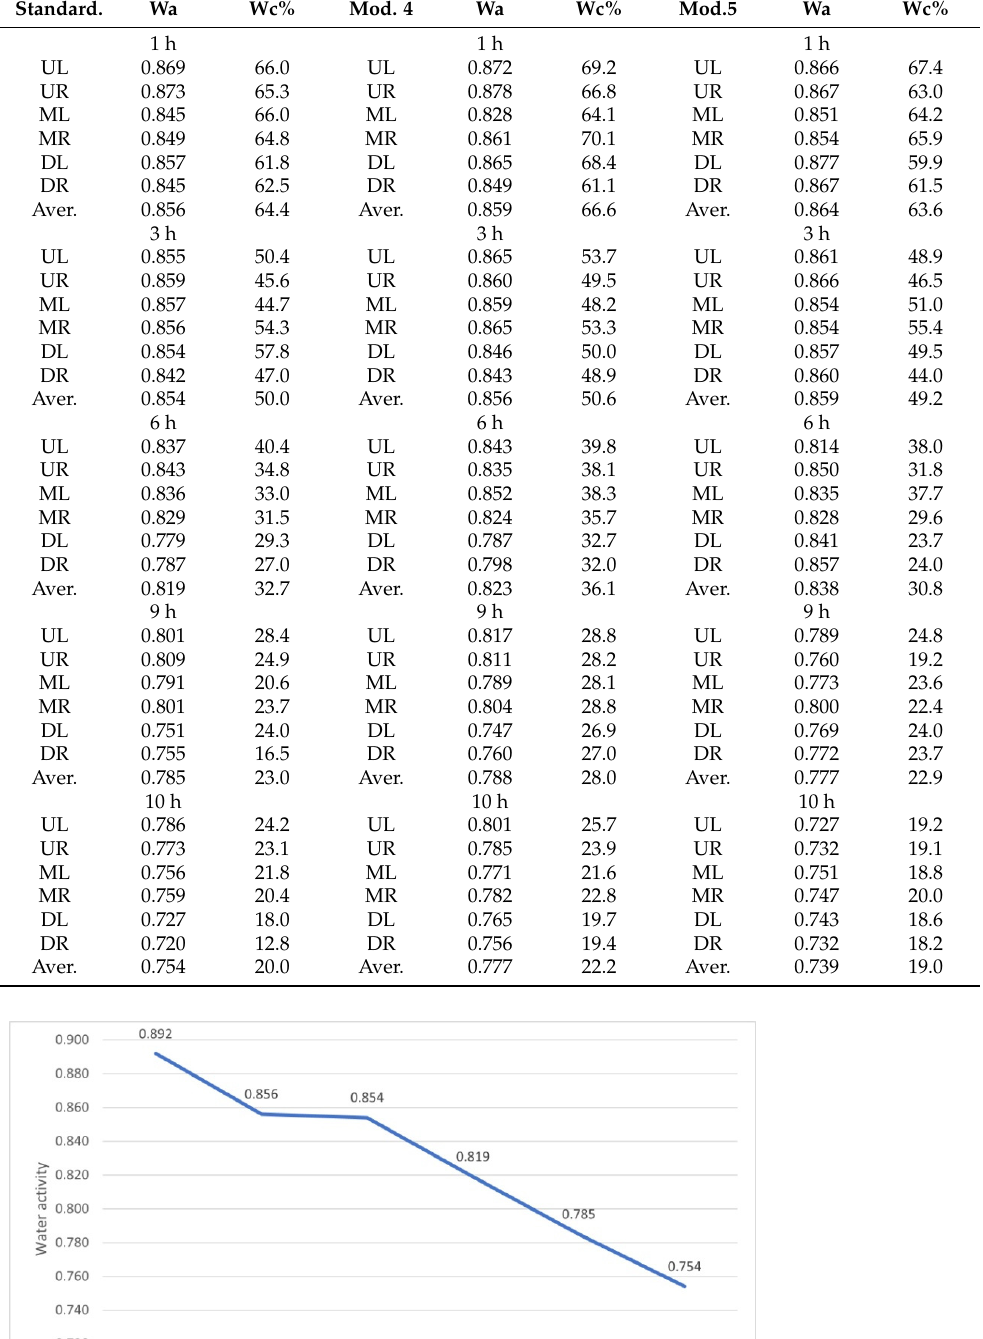
Table 2. Comparison of product moisture and water activity in the tested chambers at selected hours. Standard.